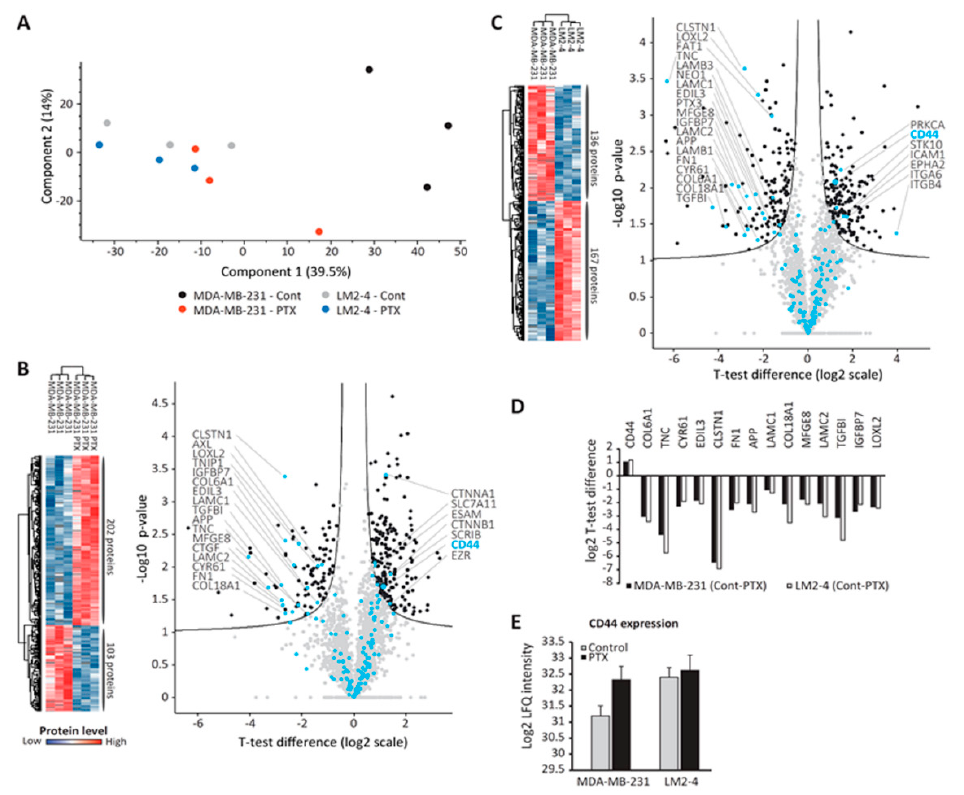
Figure 5. CD44 is a differentially expressed protein found in highly metastatic and PTX-treated TMPs. TMPs collected from MDA-MB-231 or LM2-4 cells exposed to PTX, or not, were analyzed by mass spectrometry. ( A ) Principal component analysis shows clear separation between MDA-MB-231 control and the rest of the samples. ( B , C ) Heatmap (left) and volcano plot (right) for the comparison between control and PTX-treated MDA-MB-231 ( B ) or control MDA-MB-231 and LM2-4 ( C ). In blue- “cell adhesion” proteins based on Gene Otology Biological Process category. ( D ) t -test difference (log2 scale) of the “cell adhesion” proteins that were common to both comparisons. ( E ) CD44 label-free quantification (LFQ)-intensity in MDA-MB-231 and LM2-4 cells with and without PTX. The proteomic analysis was performed when n = 3 repeats / group. All the results and graphs presented are statistically significant calculated by t -test and false discovery rate (FDR) test described in Materials and Methods.